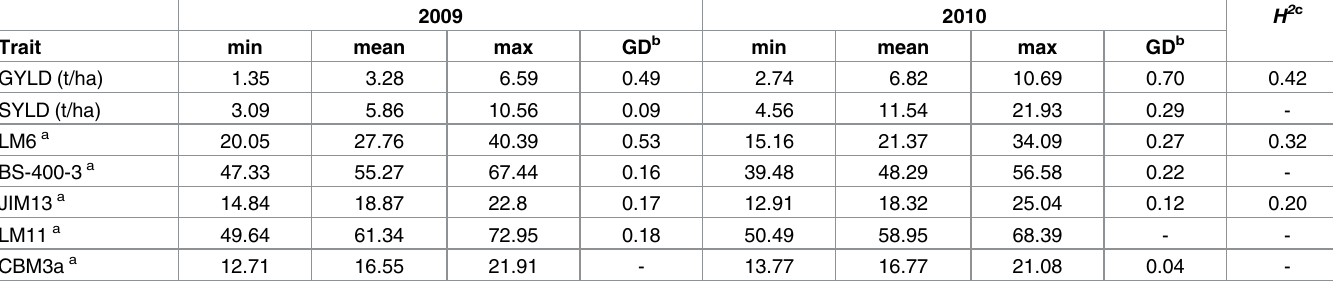
Table 1. Descriptivestatistics for field trials.